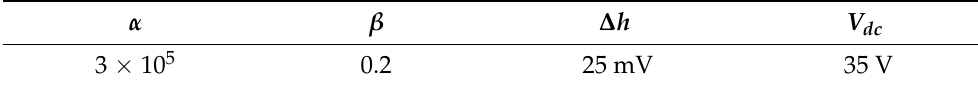
Figure 8. Plot of normalized voltage versus frequency. Table 2. Amplifier